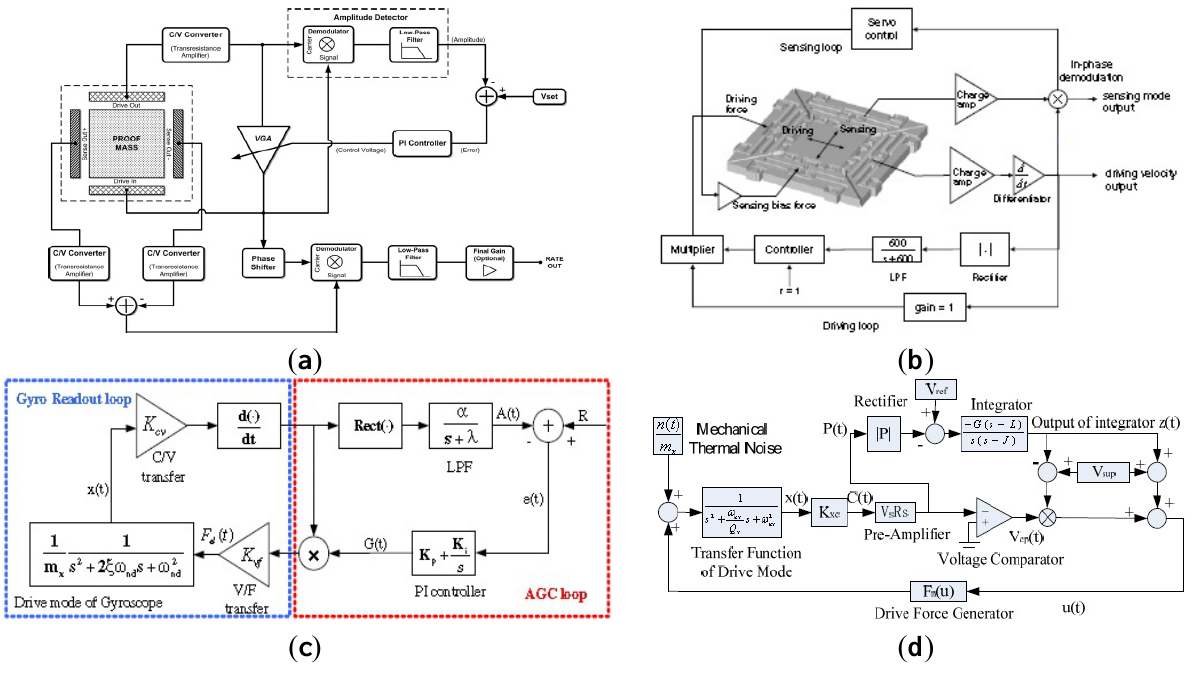
Figure 29. Analog AGC schematics. ( a ) Middle East Technical University. ( b ) Seoul National University. ( c ) PKU. ( d ) Southeast